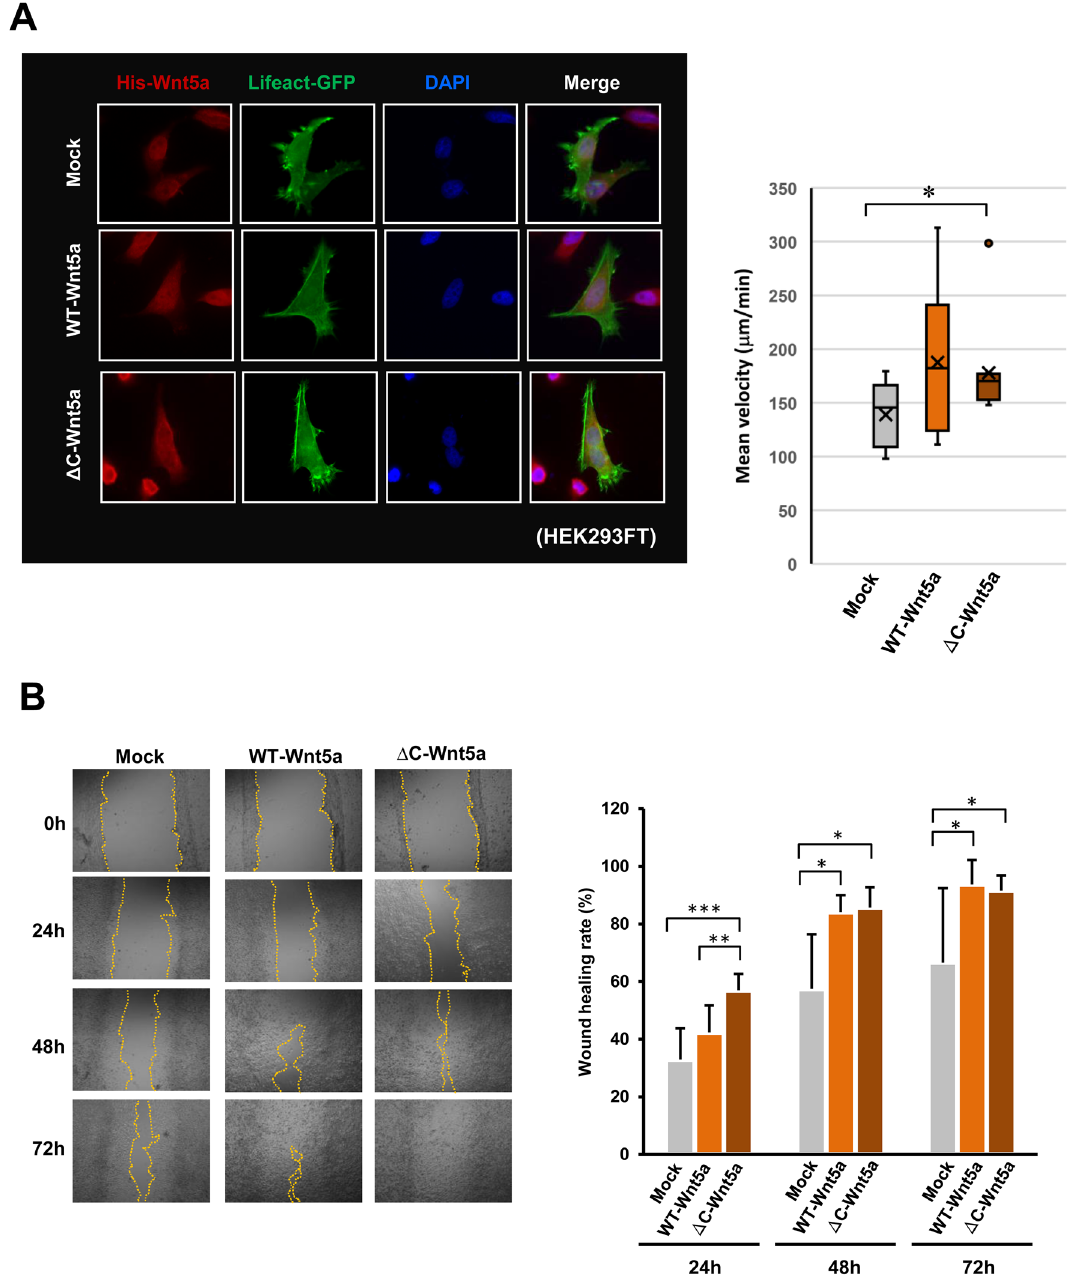
Figure 6. The ΔC-Wnt5a induces a higher cell velocity and an invasion rate than the WT-Wnt5a. ( A ) HEK293FT cells overexpressing Wnt5a-His and Lifeact-GFP were subjected to the cell velocity analysis. The movements of HEK293FT cells (expressing mock, the WT-Wnt5a-His, or the ΔC-Wnt5a-His, 10 cells each) were monitored with BioStation live cell imaging system (Nikon, Corp.), and the mean velocity was calculated using ADAPT software. The analysis shows that the mean velocity significantly increased in the ΔC-Wnt5a overexpressing cells compared with the mock cells with the empty vector (n = 10, mean ± SD, * P < 0.05). ( B ) Wound-healing assays were conducted in HEK293FT cells overexpressing the empty vector (mock), the WT-Wnt5a-His, or the ΔC-Wnt5a-His. The wound-healing rate was calculated at 24, 48, and 72 h after the wound formation as {100% − [(wound area at the time)/(wound area at 0 h) × 100%)]}. The graph demonstrates that Wnt5a expressing cells show significantly higher wound-healing rates compared with the mock control cells. Moreover, the wound-healing rate of the ΔC-Wnt5a expressing cells was significantly higher than the WT-Wnt5a expressing cells at 24 h (n = 6, mean ± SD, * P < 0.05; ** P < 0.01; *** P <